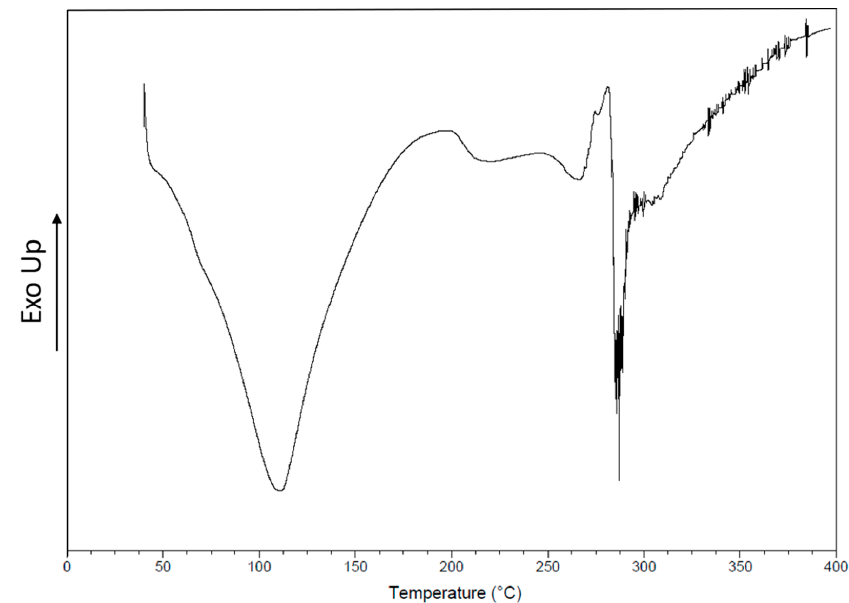
Figure 6. Differential scan calorimetry (DSC) curve showing the thermal behavior of the scaffold during a first heating run.